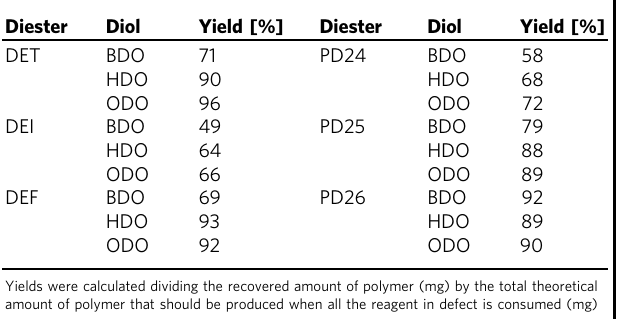
Table 1 Yields of the enzymatic synthesis reactions in DPE after the precipitation and puri fi cation